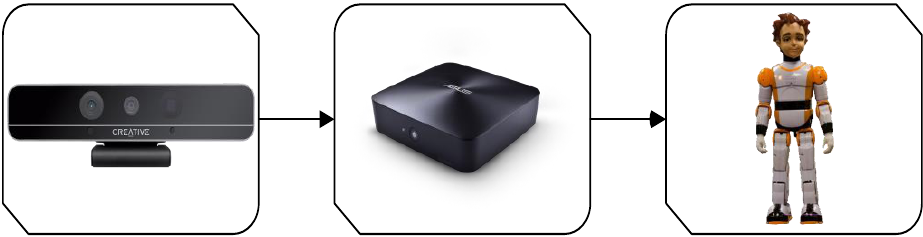
Figure 1. Experimental setup. Starting from the left: Intel® RealSense™ (model F200), computer and ZECA robot.